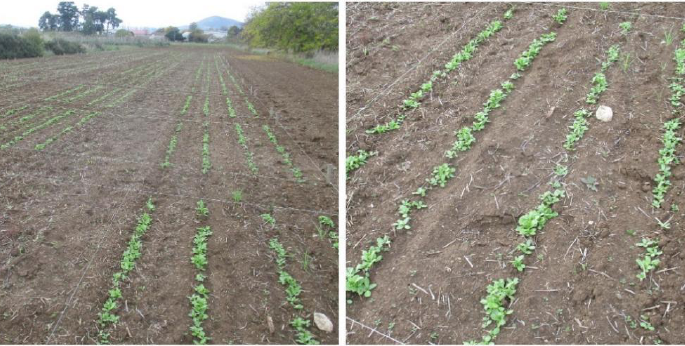
Figure 1. Experimental field (plot size: 2 × 3 m, density: 26 plants m 2 ) of milk thistle in the second experimental period on 20 November 2020. Table 1. Description of organic and inorganic fertilization treatments. Fertilizers Dose Application Time Sheep Manure 13 t ha − 1